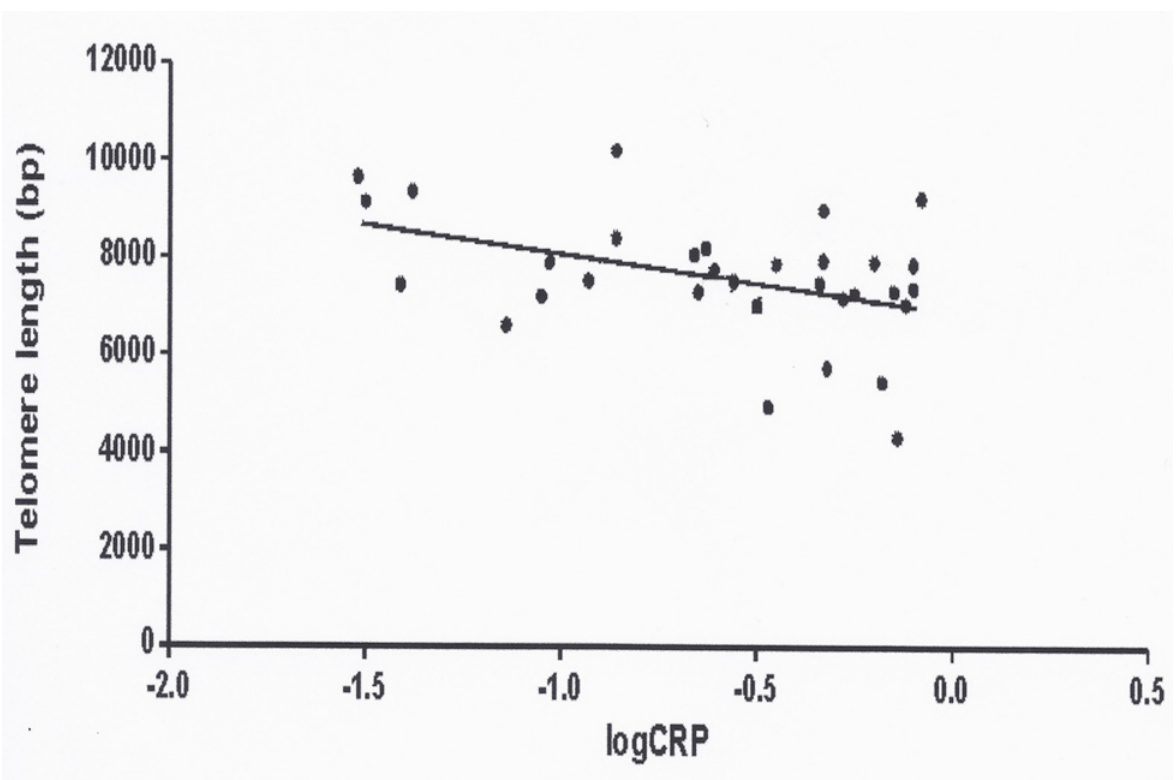
Fig 5. Correlations between C-reactive protein (expressed as logarithm) and telomere length (in base pairs = bp) in patients with Cushing ’ s syndrome (r-0.412, p 0.019).